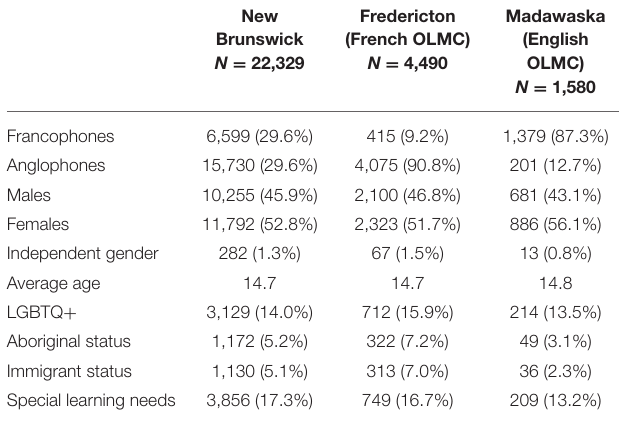
TABLE 1 | Descriptive statistics of